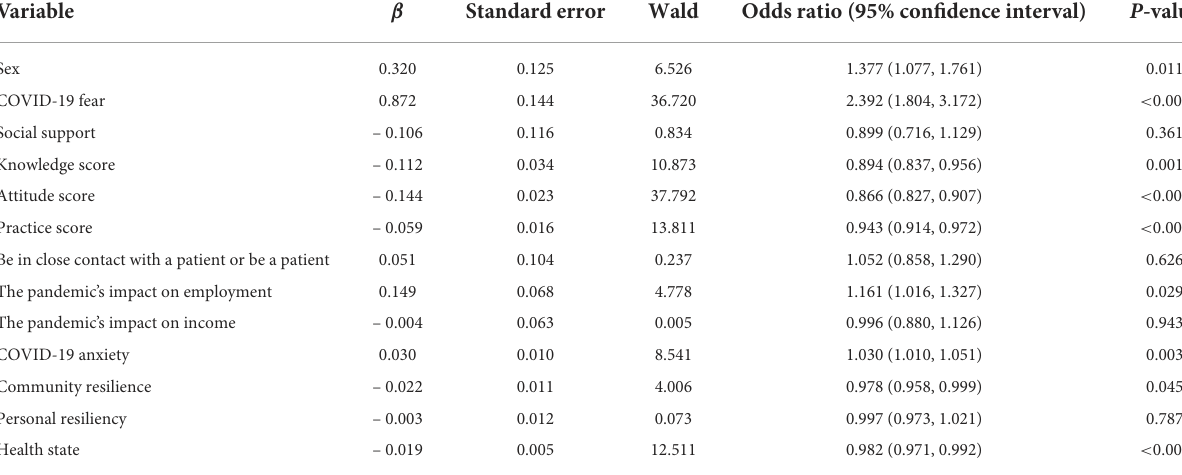
TABLE 3 Factors associated with COVID-19 pandemic fatigue among participants based on the multivariate analysis.